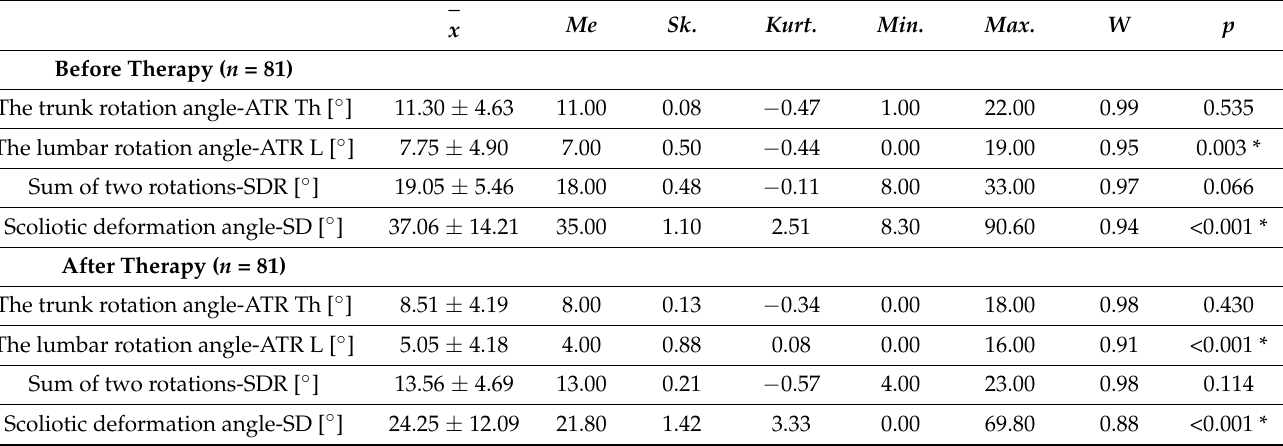
Table 3. Basic descriptive statistics of the studied variables together with the Shapiro-Wilk test for normality. ¯ x